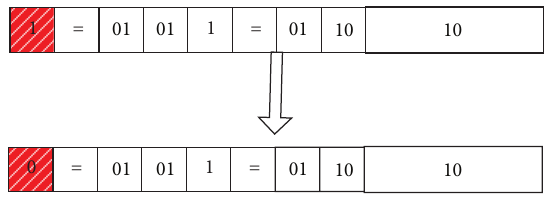
Figure 8: An example for value